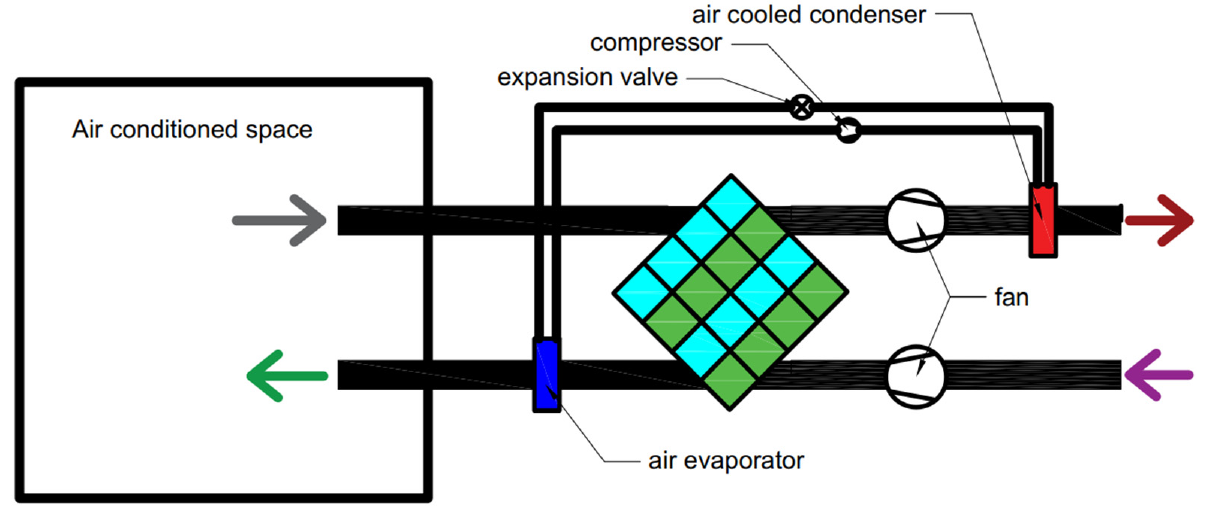
Figure 10. H-MAC diagram [52].